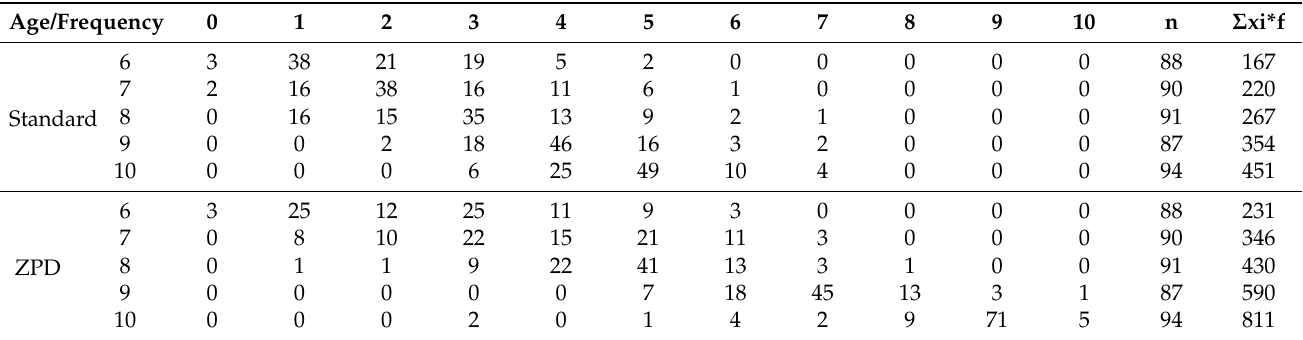
Table 3. Factor II: frequency distribution of the correct items, mean values, and the sum modalities multiplied by frequencies in the standard and ZPD conditions in age groups.